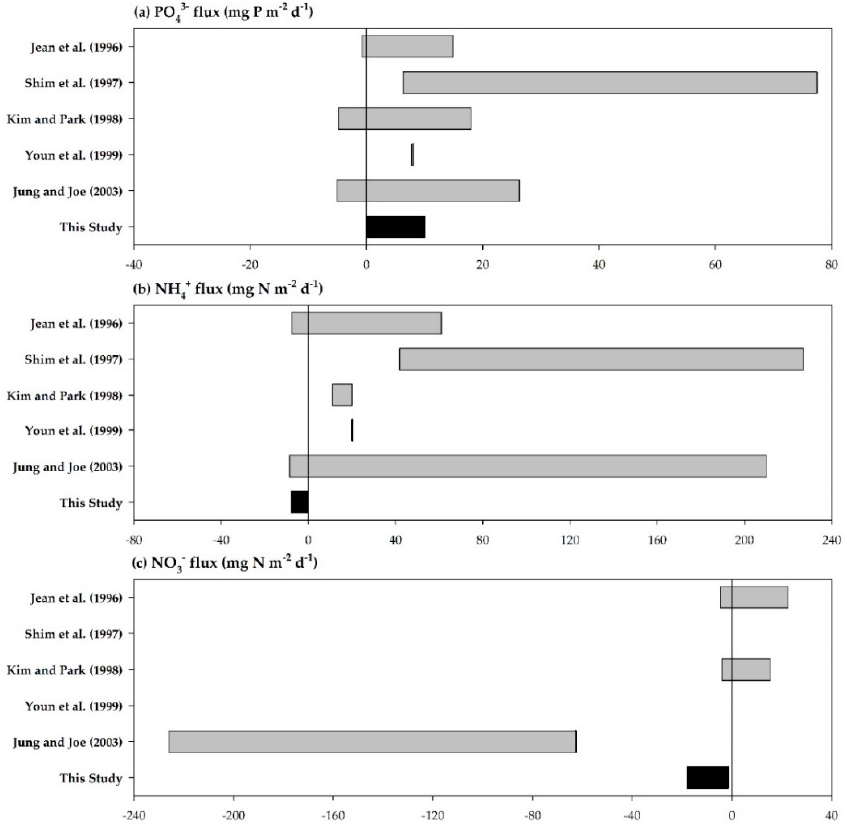
Figure 3. Comparison of nutrient release flux ranges in this experiment and previous studies. ( a ) PO 43 − flux (mg P m − 2 d − 1 ); ( b ) NH 4+ flux (mg N m − 2 d − 1 ); ( c ) NO 3 − flux (mg N m − 2 d − 1